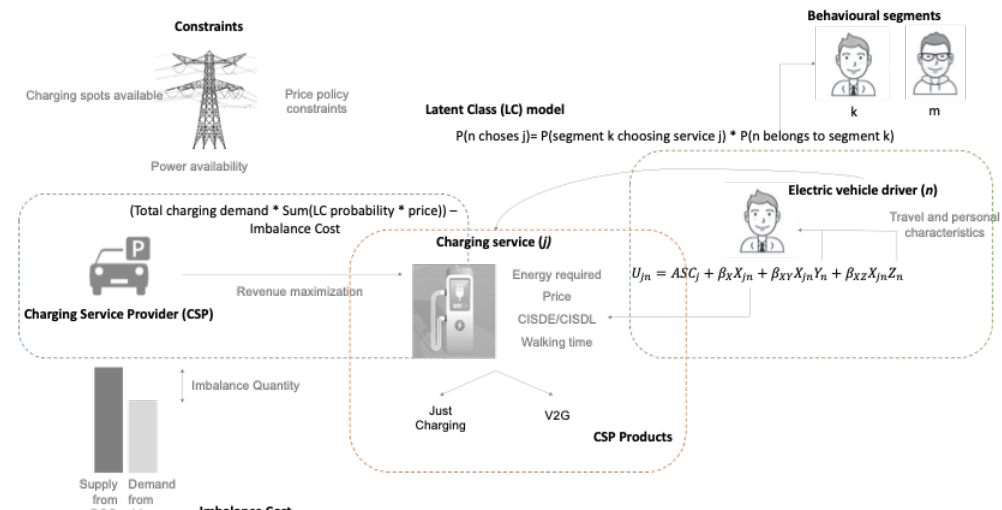
Figure 3. Decomposed elements of the choice-based revenue-management approach. The choice probability for a charging service for an electric vehicle driver affects the revenue outcome for the CSP. Simultaneously, the price, which is the decision variable of the optimization problem, can alter the choice probability, creating a closed-loop formulation with a nonlinear objective function.